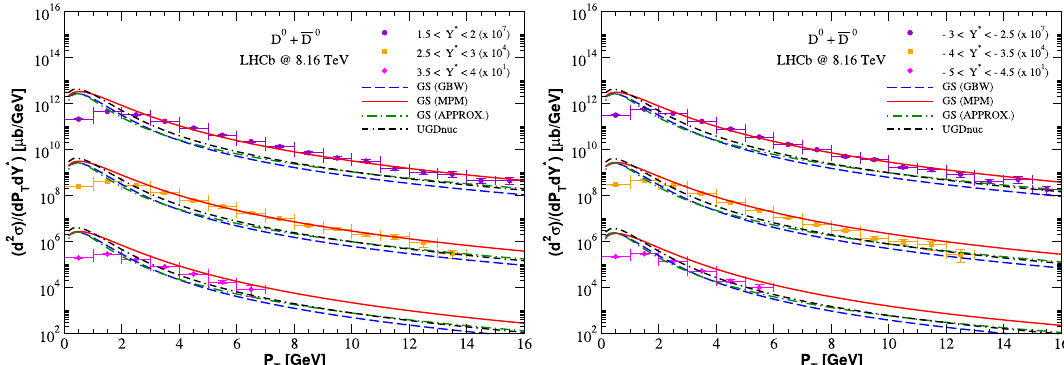
Fig. 3 Thedifferential D 0 productioncrosssectionasafunctionof P T GS(MPM) , GS(APPROX.) ,and UGDnuc modelsaredirectlycompared √ s = 8 . 16 TeV considering three forward and Y in pPb collisions at and backward rapidity bins. The predictions given by the GS (GBW) ,